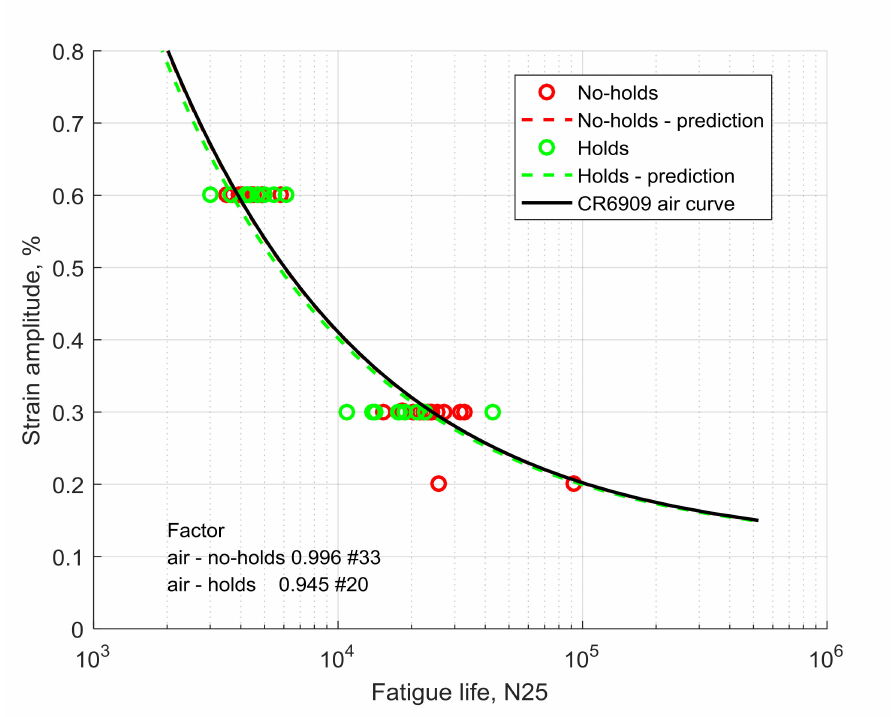
Figure 6. Effect of “INCEFA” holds on INCEFA-PLUS air fatigue life results (data as per 17 September